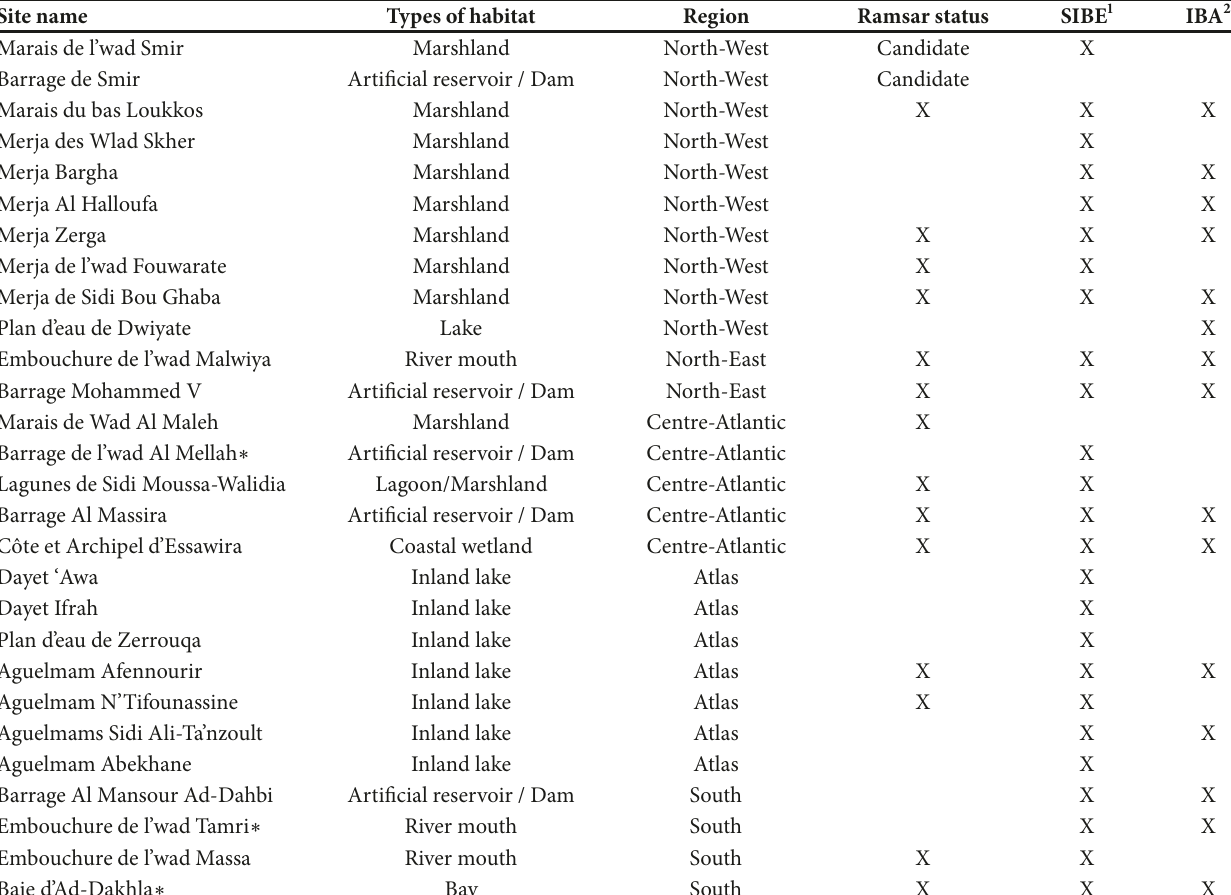
Table 3: Conservation statuses of the Ferruginous duck’s wintering